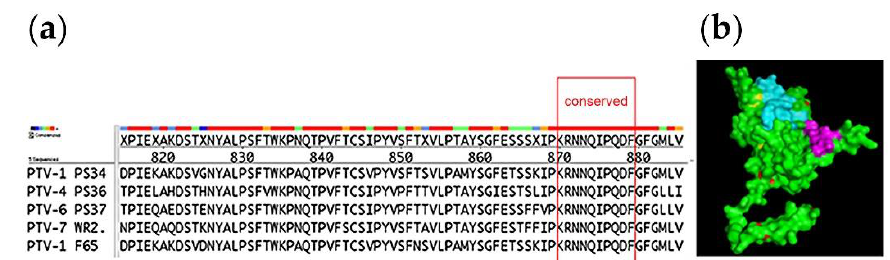
Figure 1. Bioinformatics prediction of an epitope conserved among porcine teschoviruses. ( a ) The left panel: Multiple sequences alignment of the GH loop (aa 183–195) of VP1 of 5 strains of PTV revealed the highly conserved “RNNQIPQDF” sequence. Note that amino acids 820 to 880 are numbered from the capsid polyprotein gene, which is constituted by VP4 / VP2 / VP3 / VP1 genes. The polyprotein is later processed into individual proteins including VP1. ( b ) The right panel: The identified conserved RNNQIPQDF epitope (highlighted in purple) mapped within a 3D structure of the VP1 of PTV produced by the PyMOL visualization tool. The green area indicates the backbone of VP1 while the blue area indicates where the BC loop is located.